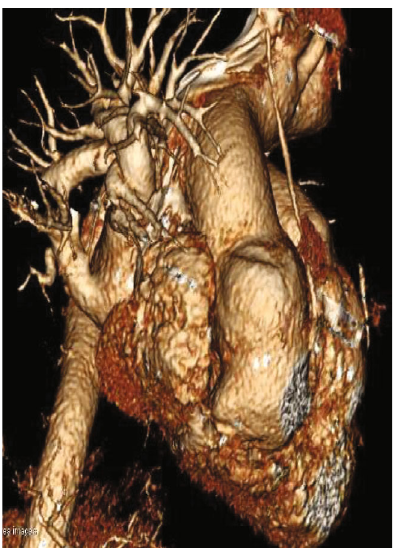
Figure 2: Computed tomography angiography of the sinus of Valsalva aneurysm, sagittal view. The right and noncoronary cusps are fused, separated by a raphe.